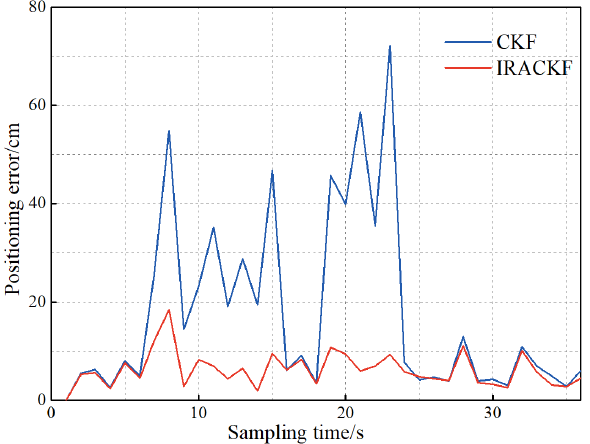
Figure 14. The position error of each filter.